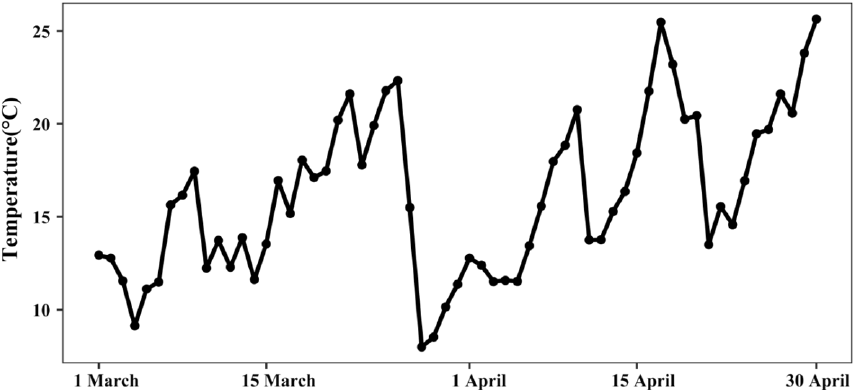
Figure 1. Temperature from March to April in 2020 at the nearest station to Baishanzu